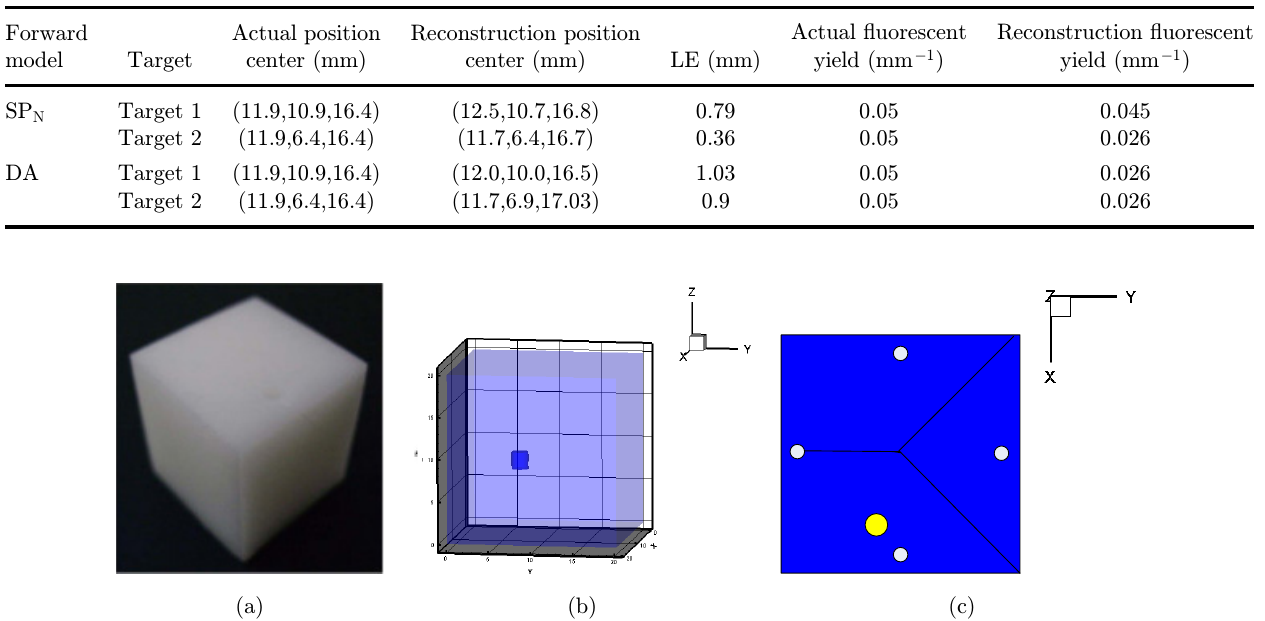
Table 6. Quantitative results of our method for double targets on ¯nal mesh.